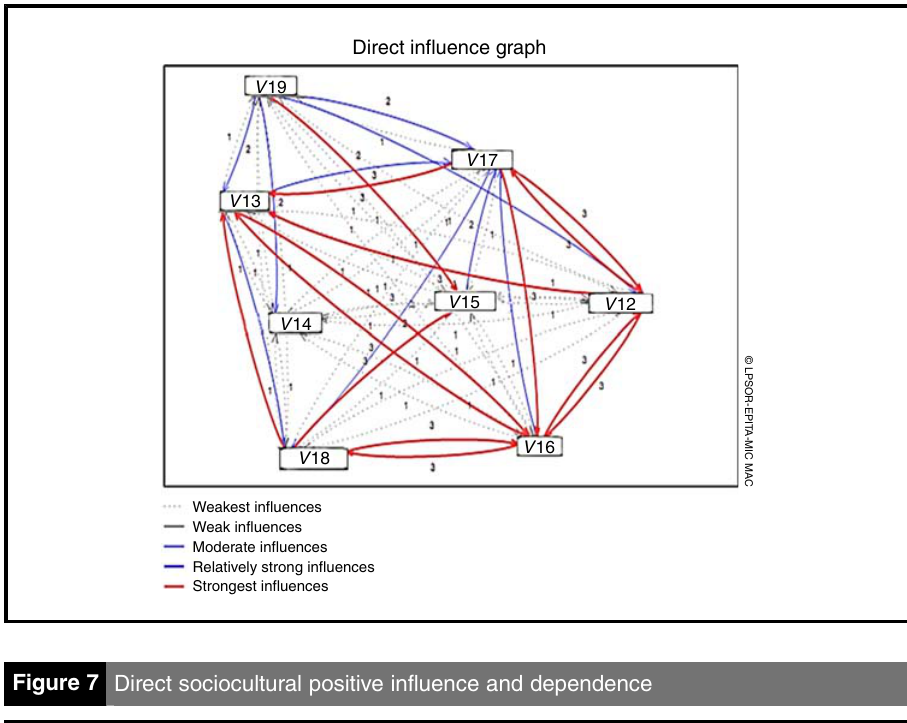
Figure 6 Economic negative influence relations